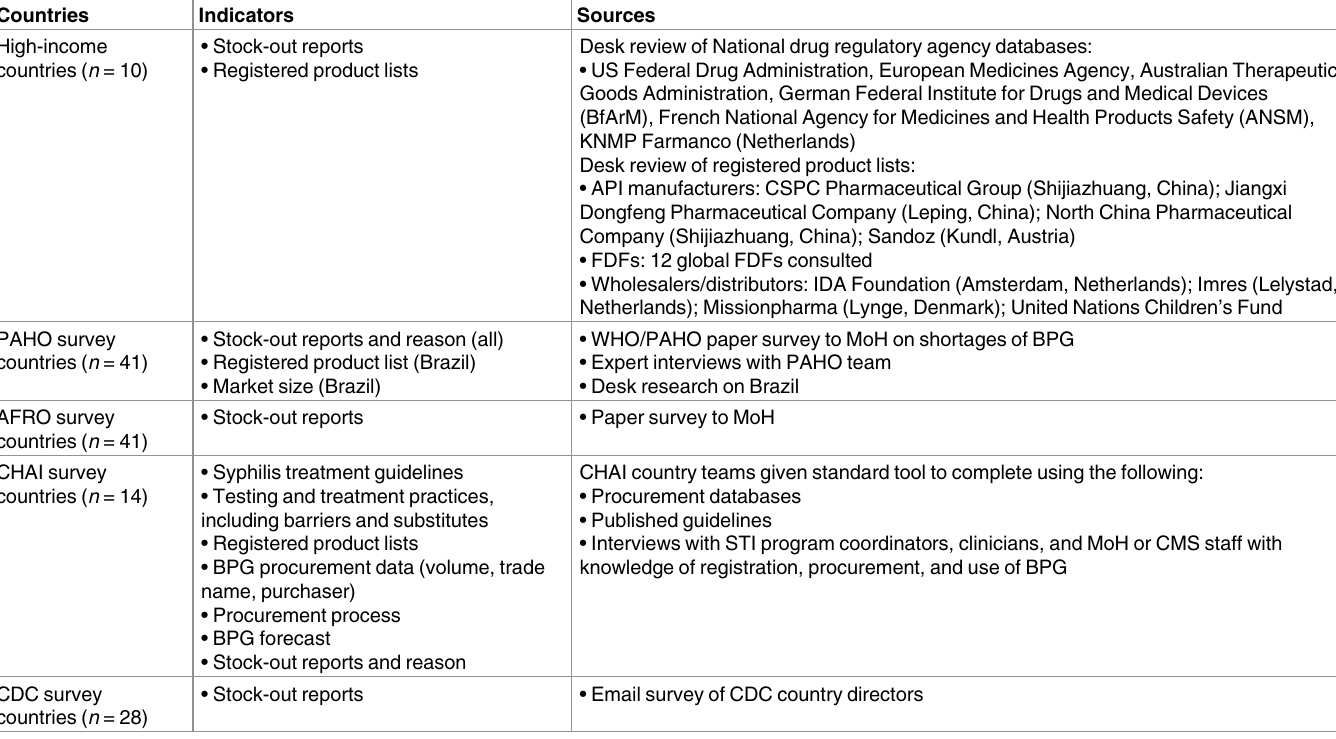
Table 2. List of indicators and sources used in BPG country